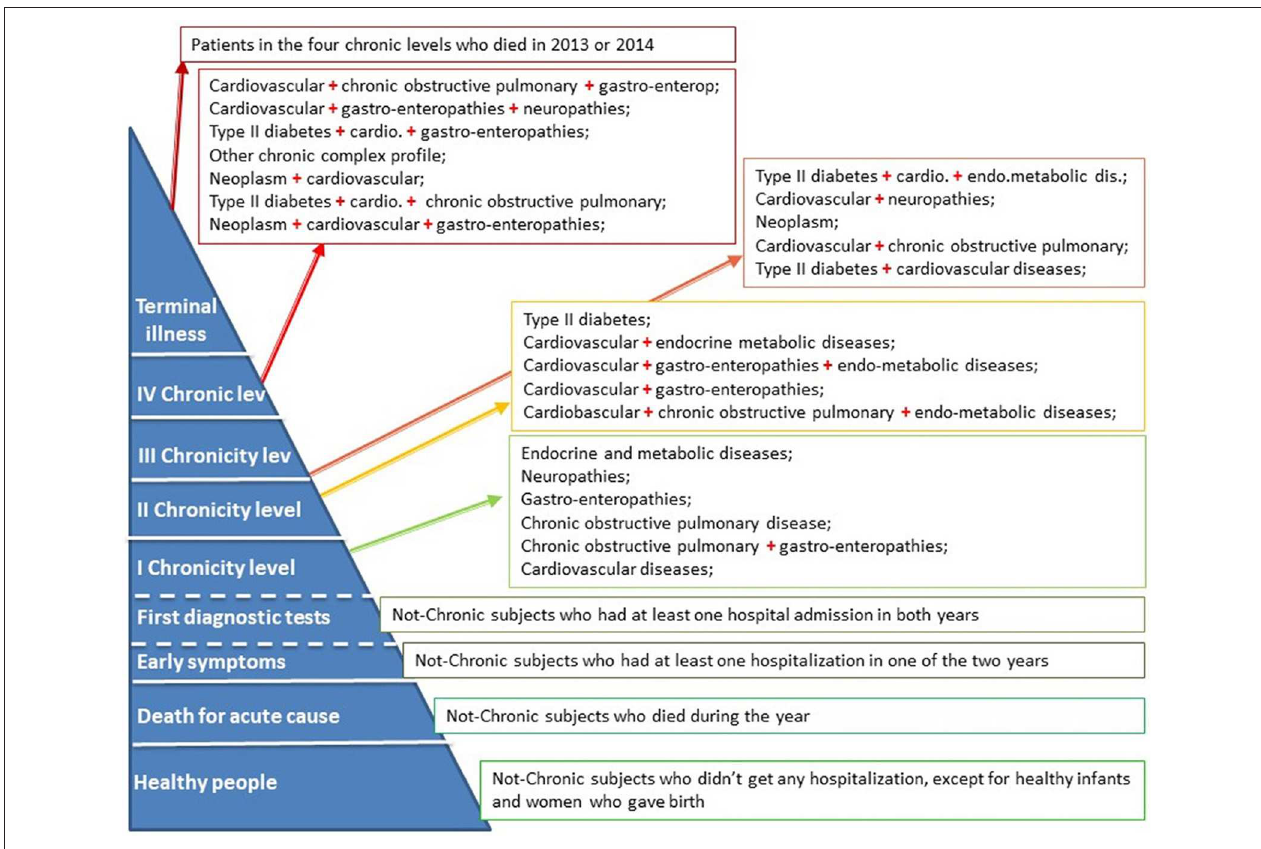
FIGURE 2 | The IPP